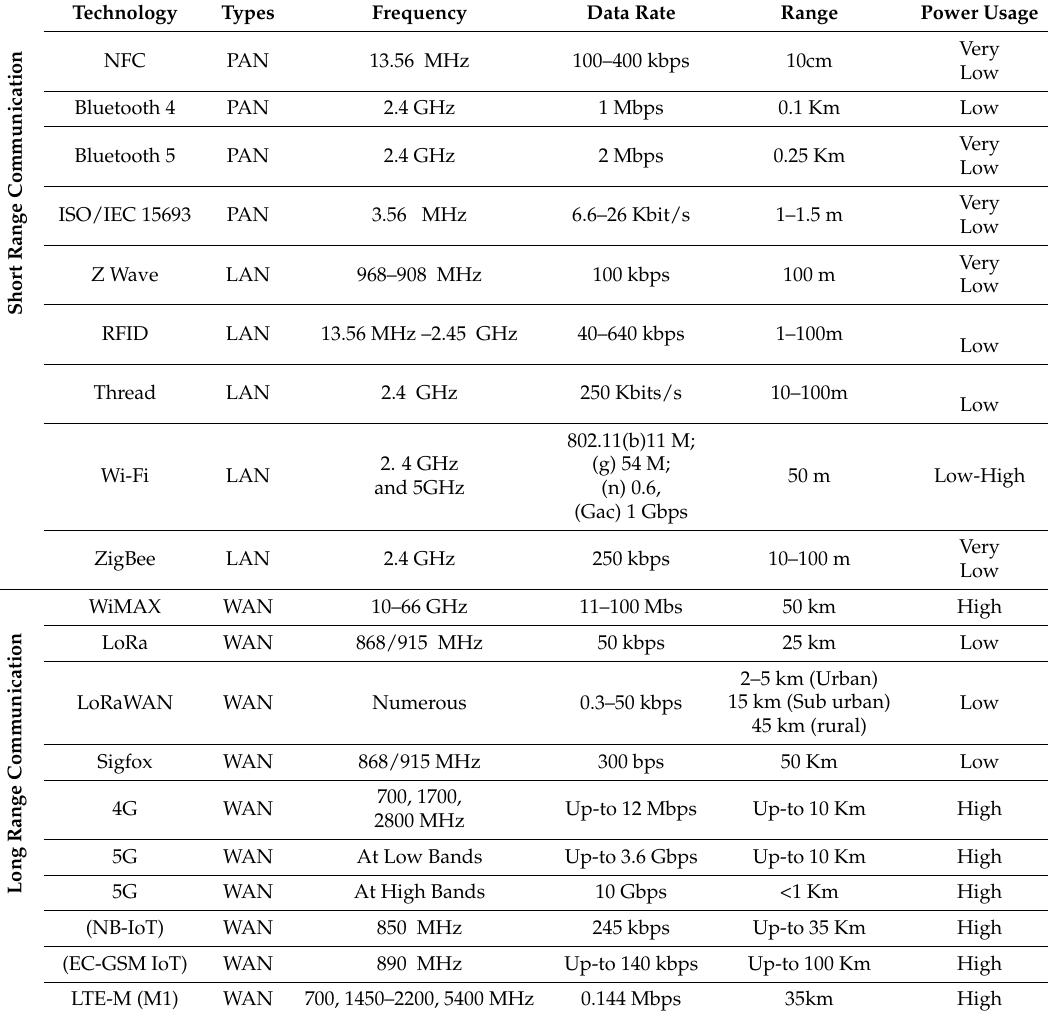
Table 2. Comparison of existing proposed wireless communication technologies and their parameters for smart